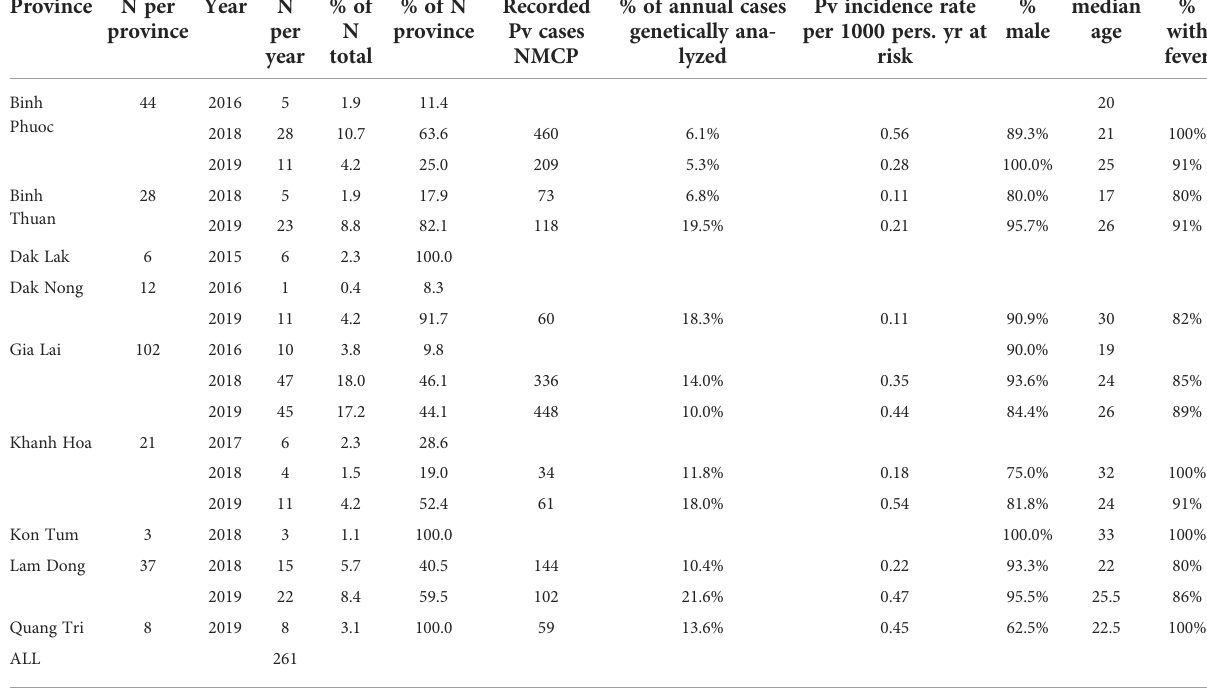
TABLE 3 Vietnam sample characteristics and epidemiological data from 2018 and 2019 (from NIMPE annual malaria report). Province